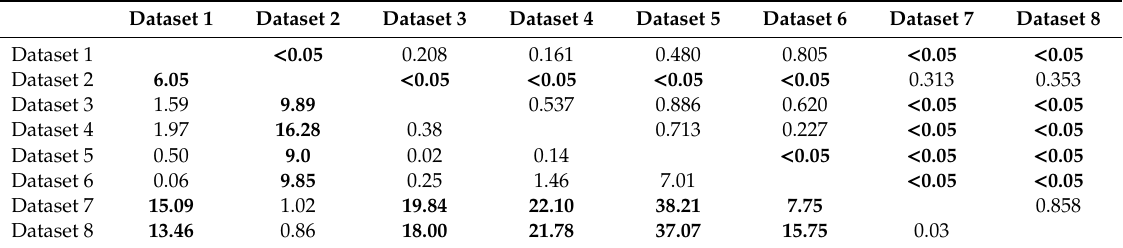
Table 4. Matrix of McNemar test showing the statistical significance of di ff erences between all classification pairs. McNemar’s test values (z 2 ) are on the left side of the diagonal, p -values on the right side. Bold value indicates significantly di ff erent classification ( p <